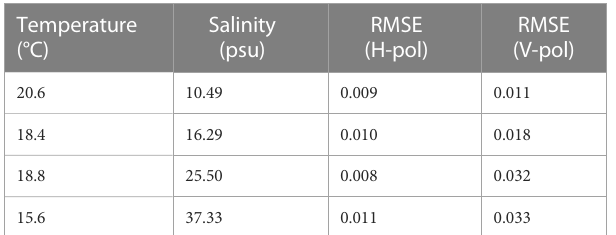
TABLE 1 Water properties of the measurements and RMS errors for the Camps et al. developed emissivity model compared to experimental